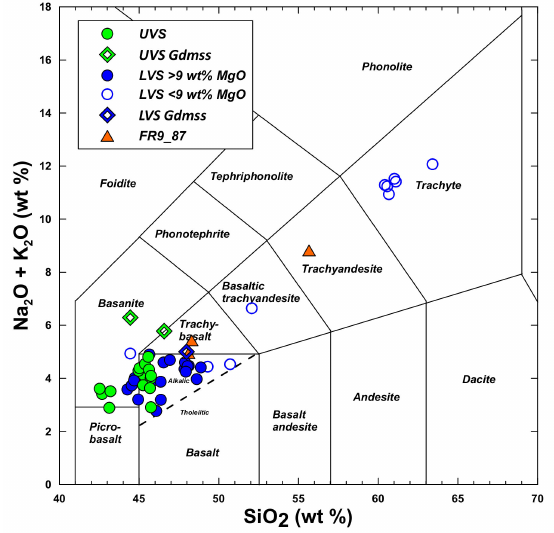
Figure 5. Christmas Island lava plotted in the total alkali (Na 2 O + K 2 O) vs. silica (SiO 2 ) (TAS) classification for igneous volcanic rocks [54]. Data from Tables S3 and S5.